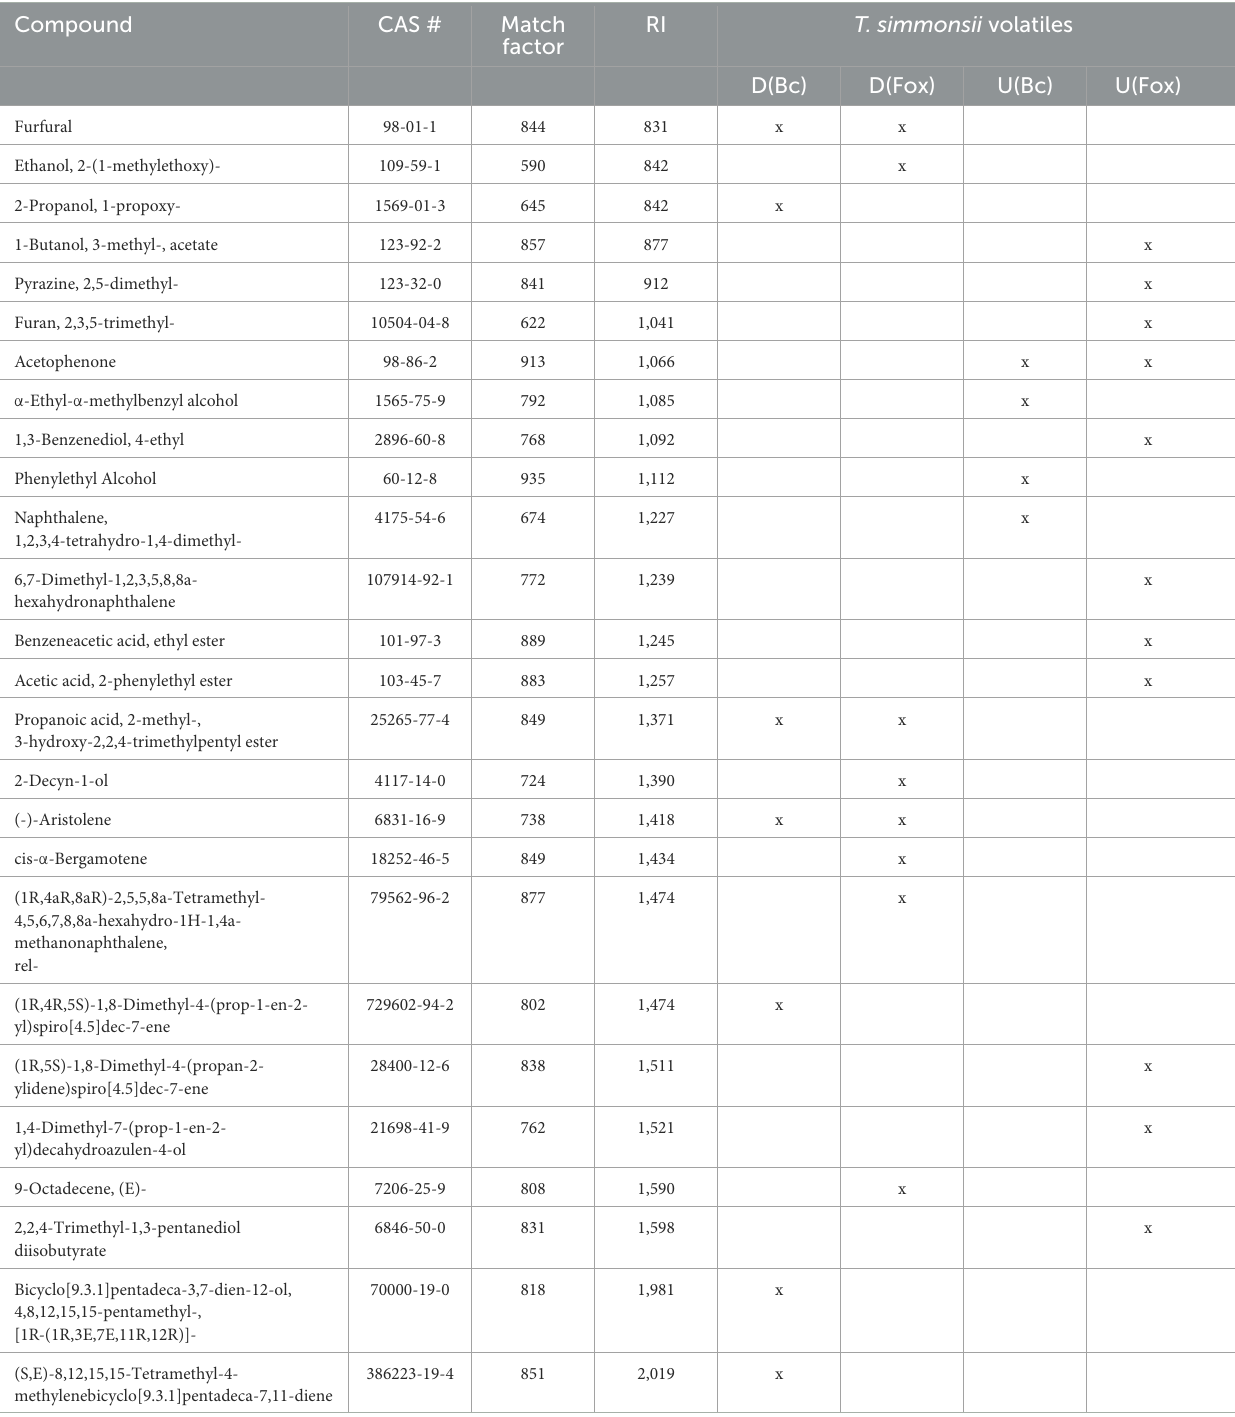
TABLE 3 List of volatiles emitted by Trichoderma with significantly modified abundance after exposure to Botrytis and Fusarium volatiles.